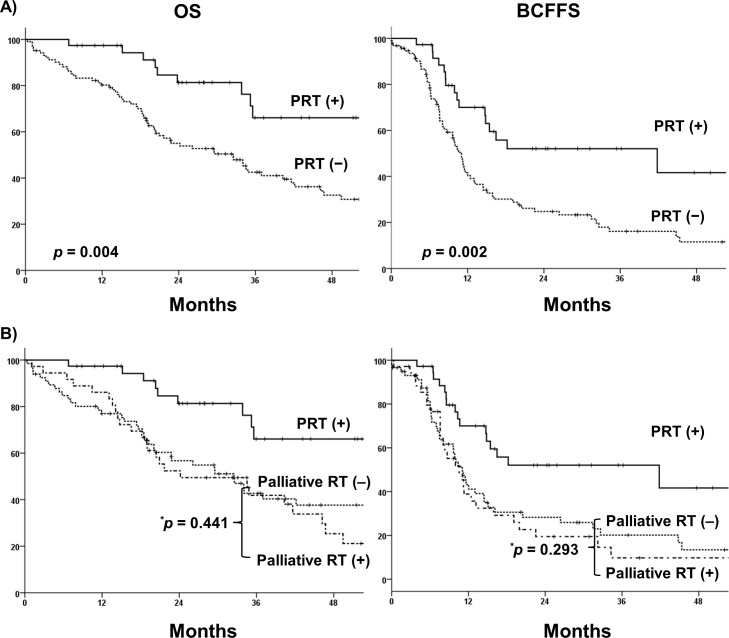
(A) Kaplan–Meier curves for overall survival (OS) and biochemical failure-free survival (BCFFS) of patients receiving prostate radiotherapy (PRT) and those who did not. OS (p = 0.004) and BCFFS (p = 0.002) were better in PRT patients than in non-PRT patients. (B) Kaplan-Meier curves for overall survival (OS) and biochemical failure-free survival (BCFFS) of non-prostate radiotherapy (PRT) patients with and without palliative radiotherapy (RT).In the non-PRT group, OS and BCFFS did not differ significantly between patients receiving palliative RT and those receiving non-palliative RT.